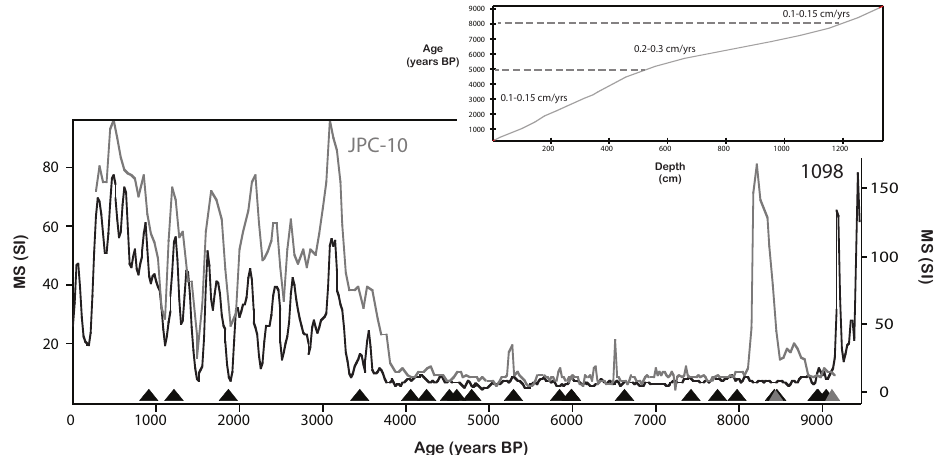
Fig. 2. Age model and sedimentation rate. The main panel represents the magnetic susceptibility (MS) correlation between the core JPC-10 and the ODP Site 1098. Grey and black markers indicate respective 14 C dates for core JPC-10 and Site 1098. The upper, smaller panel shows the sedimentation of core